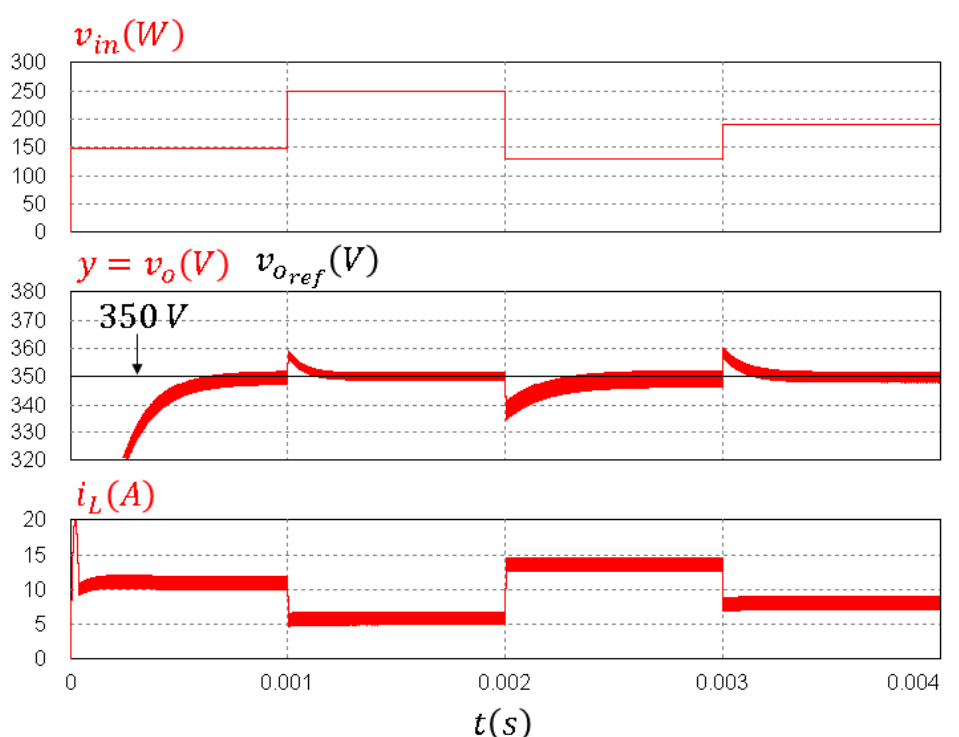
Figure 8. Response to disturbances in the input voltage when a the converter feds a